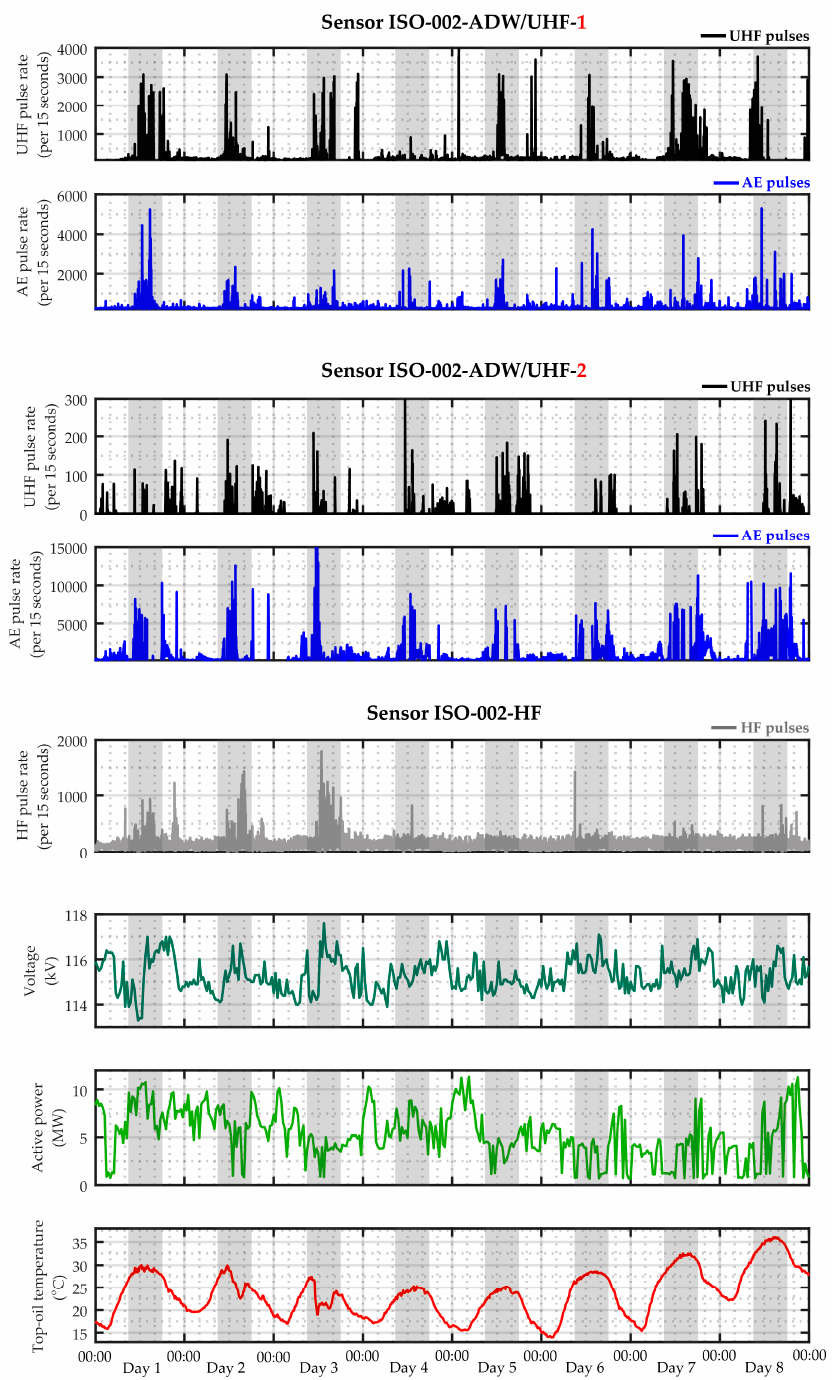
Figure 32. Partial discharges intensity characteristics, voltage, load, and oil temperature characteristics registered during 8-days-operation of the monitoring system on the 31.5 MVA substation power